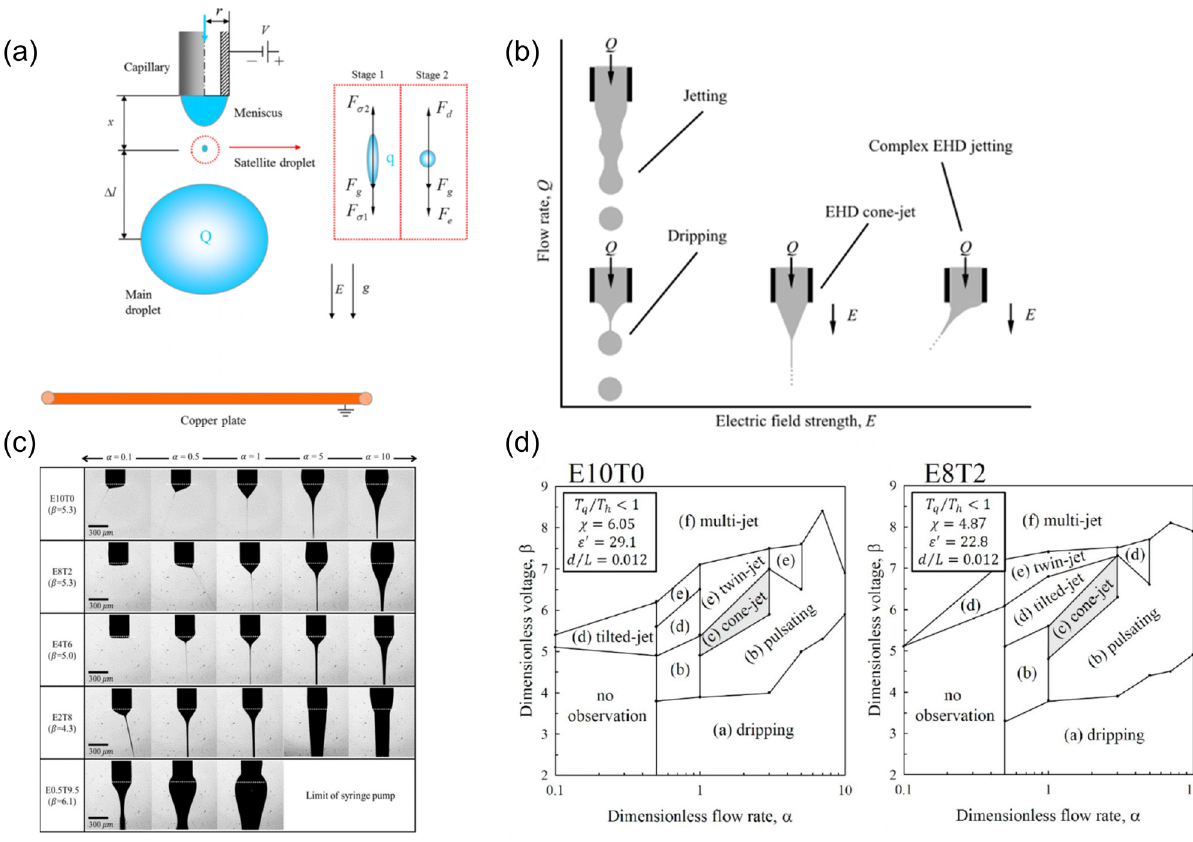
Figure 3: ( a ) Schematic diagram of force action of satellite droplets produced by low - viscosity liquid with or without the electric fi eld. Reproduced from ref. [ 51 ] with permission from American Institute of Physics. ( b ) Several di ff erent injection modes as the electric fi eld and fl ow rate change. Reproduced from ref. [ 53 ] with permission from Cambridge University Press. ( c ) Changing the nondimensional parameters of fl ow rate α and voltage β changes in injection behavior. ( d ) Four mixed ink ( E10T0, E8T2, E4T6, and E2T8 ) jet behavior diagrams drawn according to fl ow rate α and voltage β . Reproduced from ref. [ 60 ] with permission from American Chemical